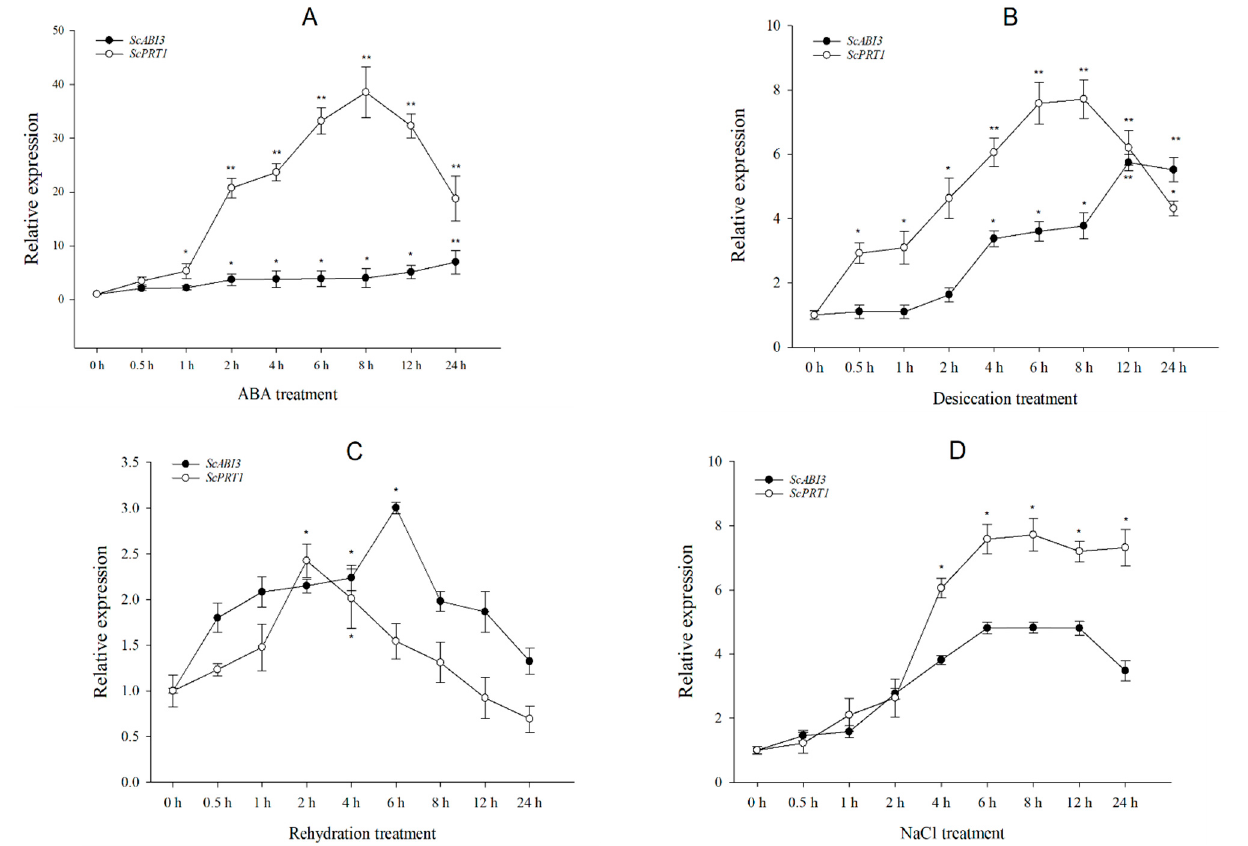
Figure 6. Expression patterns of ScABI3 and ScPRT1 in response to different stress treatments. ( A ) ABA, ( B ) dehydration, ( C ) rehydration, ( D ) NaCl treatment. The 2 −ΔΔ CT method was used in the qRT-PCR analysis, with α -tubulin as the internal reference gene and 0 h treatment as the control. Values are means ± SE of three replicates. * Indicates a significant difference ( p < 0.05). ** Indicates a substantially significant difference ( p < 0.01).